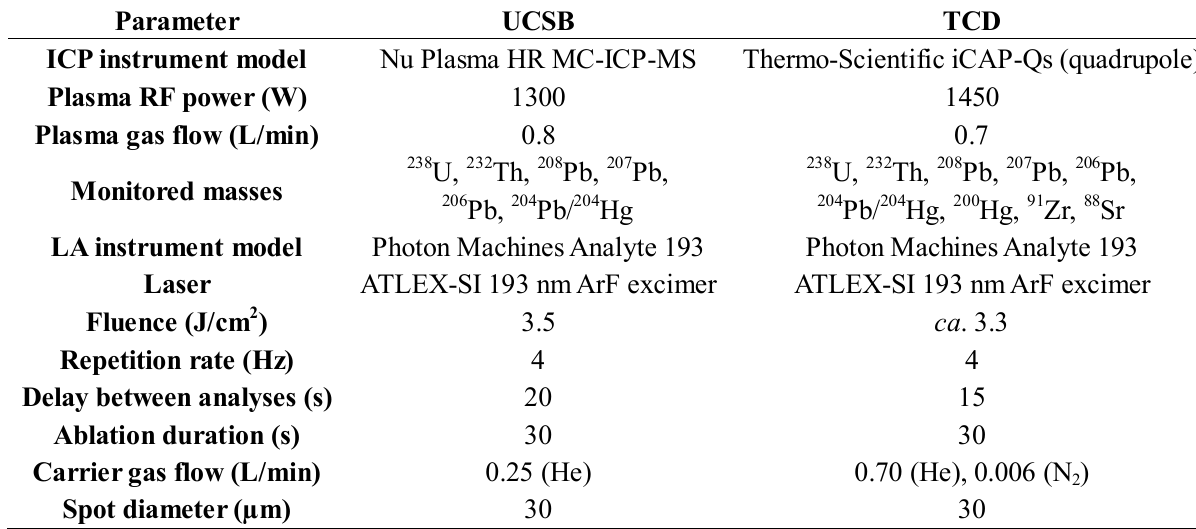
Table 1. Running conditions for ICP-MS and laser ablation at University of California, Santa Barbara (UCSB), and Trinity College, Dublin (TCD). Note that for analyses performed at TCD 91 Zr was included to monitor general signal intensity and 88 Sr was monitored to evaluate alteration (pristine or non-hydrothermal zircon does not contain significant levels of